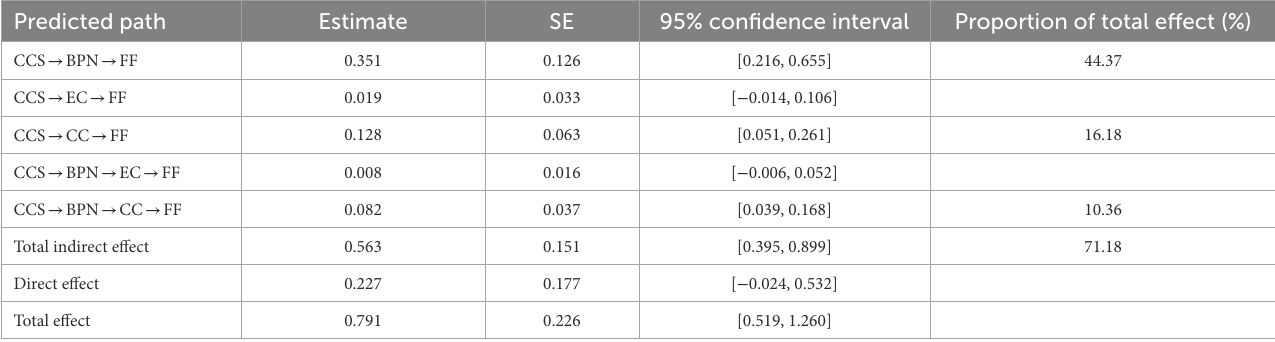
TABLE 7 Bootstrap test results for the various paths of the model. Predicted